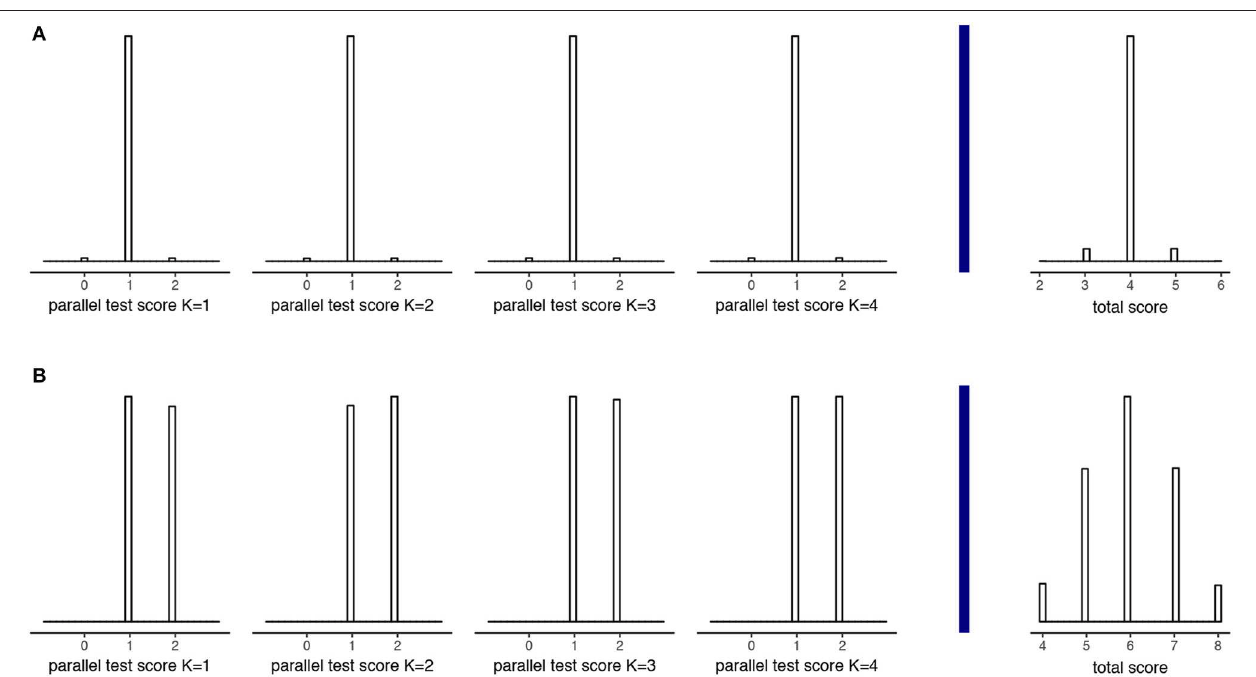
FIGURE 7 | Parallel and total test scores for two example examinees with true score 4 (A) and true score 6 (B) , both having a true error variance of 0.2 on a 12 item test with K = 4.